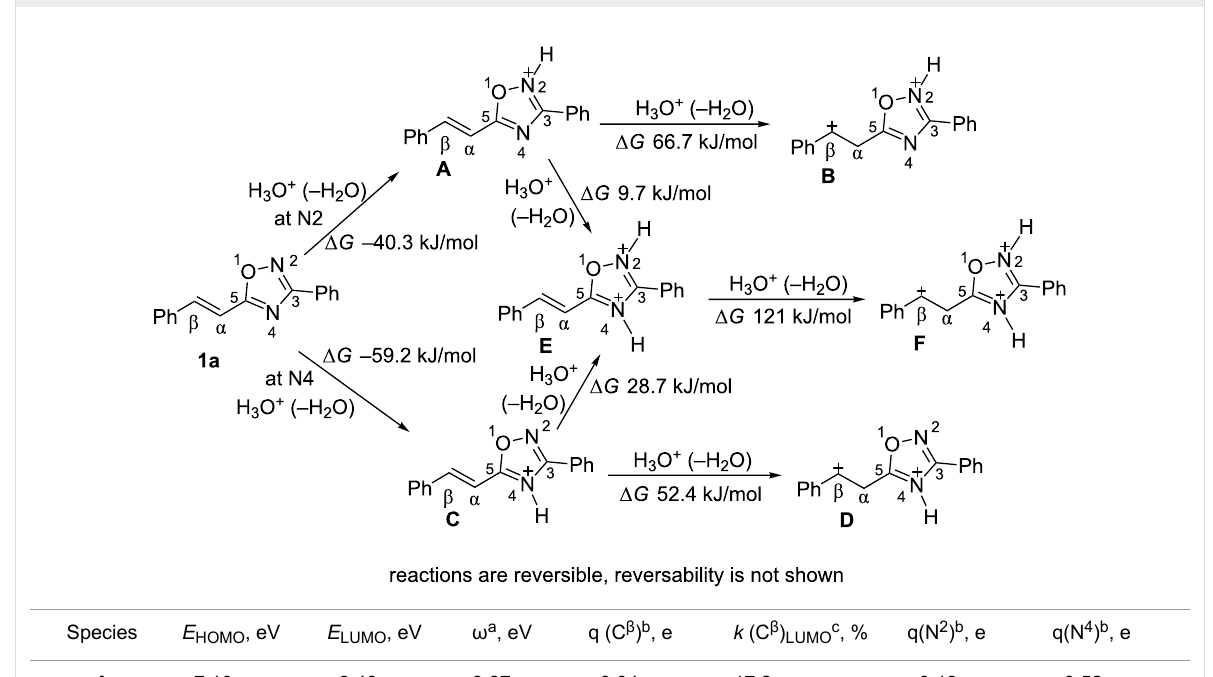
Table 1: Selected electronic characteristics for cations A – F calculated by DFT from protonation of oxadiazole 1a